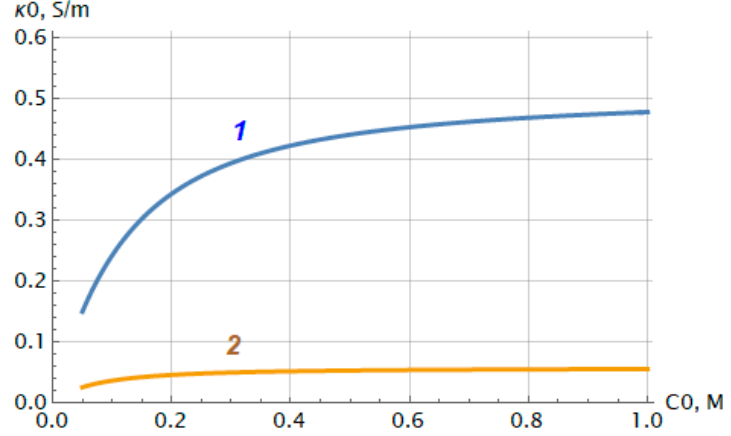
Figure 7. Predictive behavior of initial conductivity of bilayer membrane MF-4SC/PTMSP in HCl (curve 1) and NaCl (curve 2) solutions.